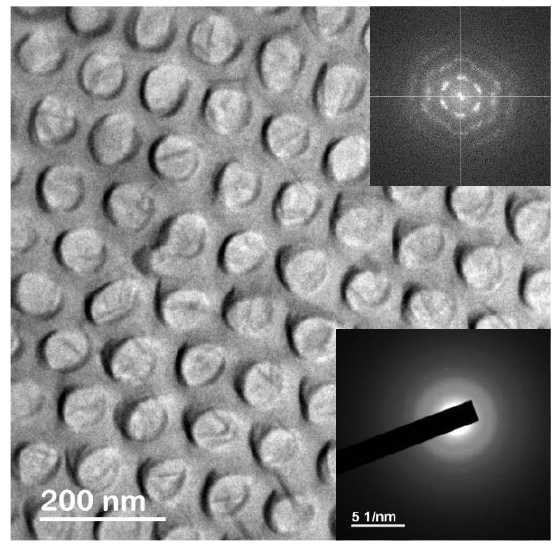
Figure 2. Transmission Electron Microscopy (TEM) image of a small region of Dy 13 Fe 87 antidots thin film after being released from the nanoporous alumina template. The Fast Fourier Transform (FFT) analysis shown in the upper inset reveals the highly hexagonal ordering degree of the antidots by replicating the nanoporous structure of the patterned alumina membrane, while the electron diffraction pattern displayed in the lower inset demonstrates the amorphous character of the deposited Dy 13 Fe 87 alloy.